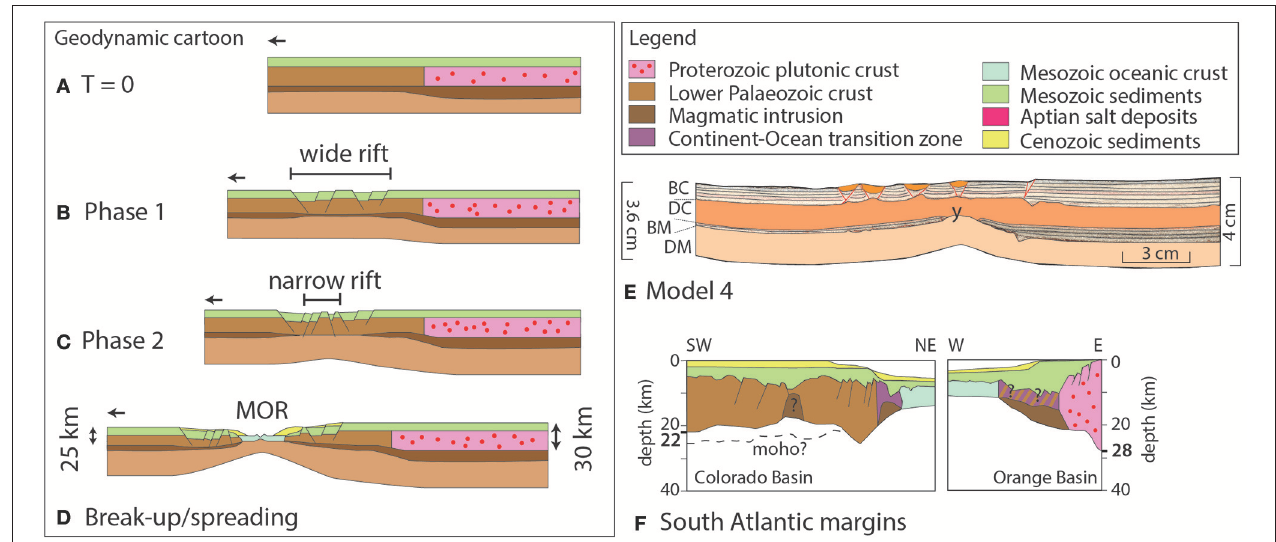
FIGURE 5 | Cartoon showing the two-phased conceptual evolution of continental break-up in a system (A) consisting of two large lithosphere segments, T = 0. (B) Phase 1 shows the distributed or wide rift formation, with normal faulting occurring in the weak segment. (C) Phase 2 shows localized or narrow deformation that occurs directly above the location where the upper mantle has failed and the weak lower crust and the weak part of the upper mantle are in direct contact. (D) Continuous extension will eventually lead to breakup above the necking point that formed during the second phase, resulting in asymmetric margins in terms of crustal thickness and basin positioning. (E) M4, with two lithospheric segments of different strength shows a small decrease in thickness for the weak segment (right side) and a very. (F) The simplified cross-section of the South Segment continental margin of the South Atlantic shows that the crustal thickness of both margins is not equal, being thinner on the South American side also the transition zones have different thicknesses and more horst and graben structures are located on the margin of the South American